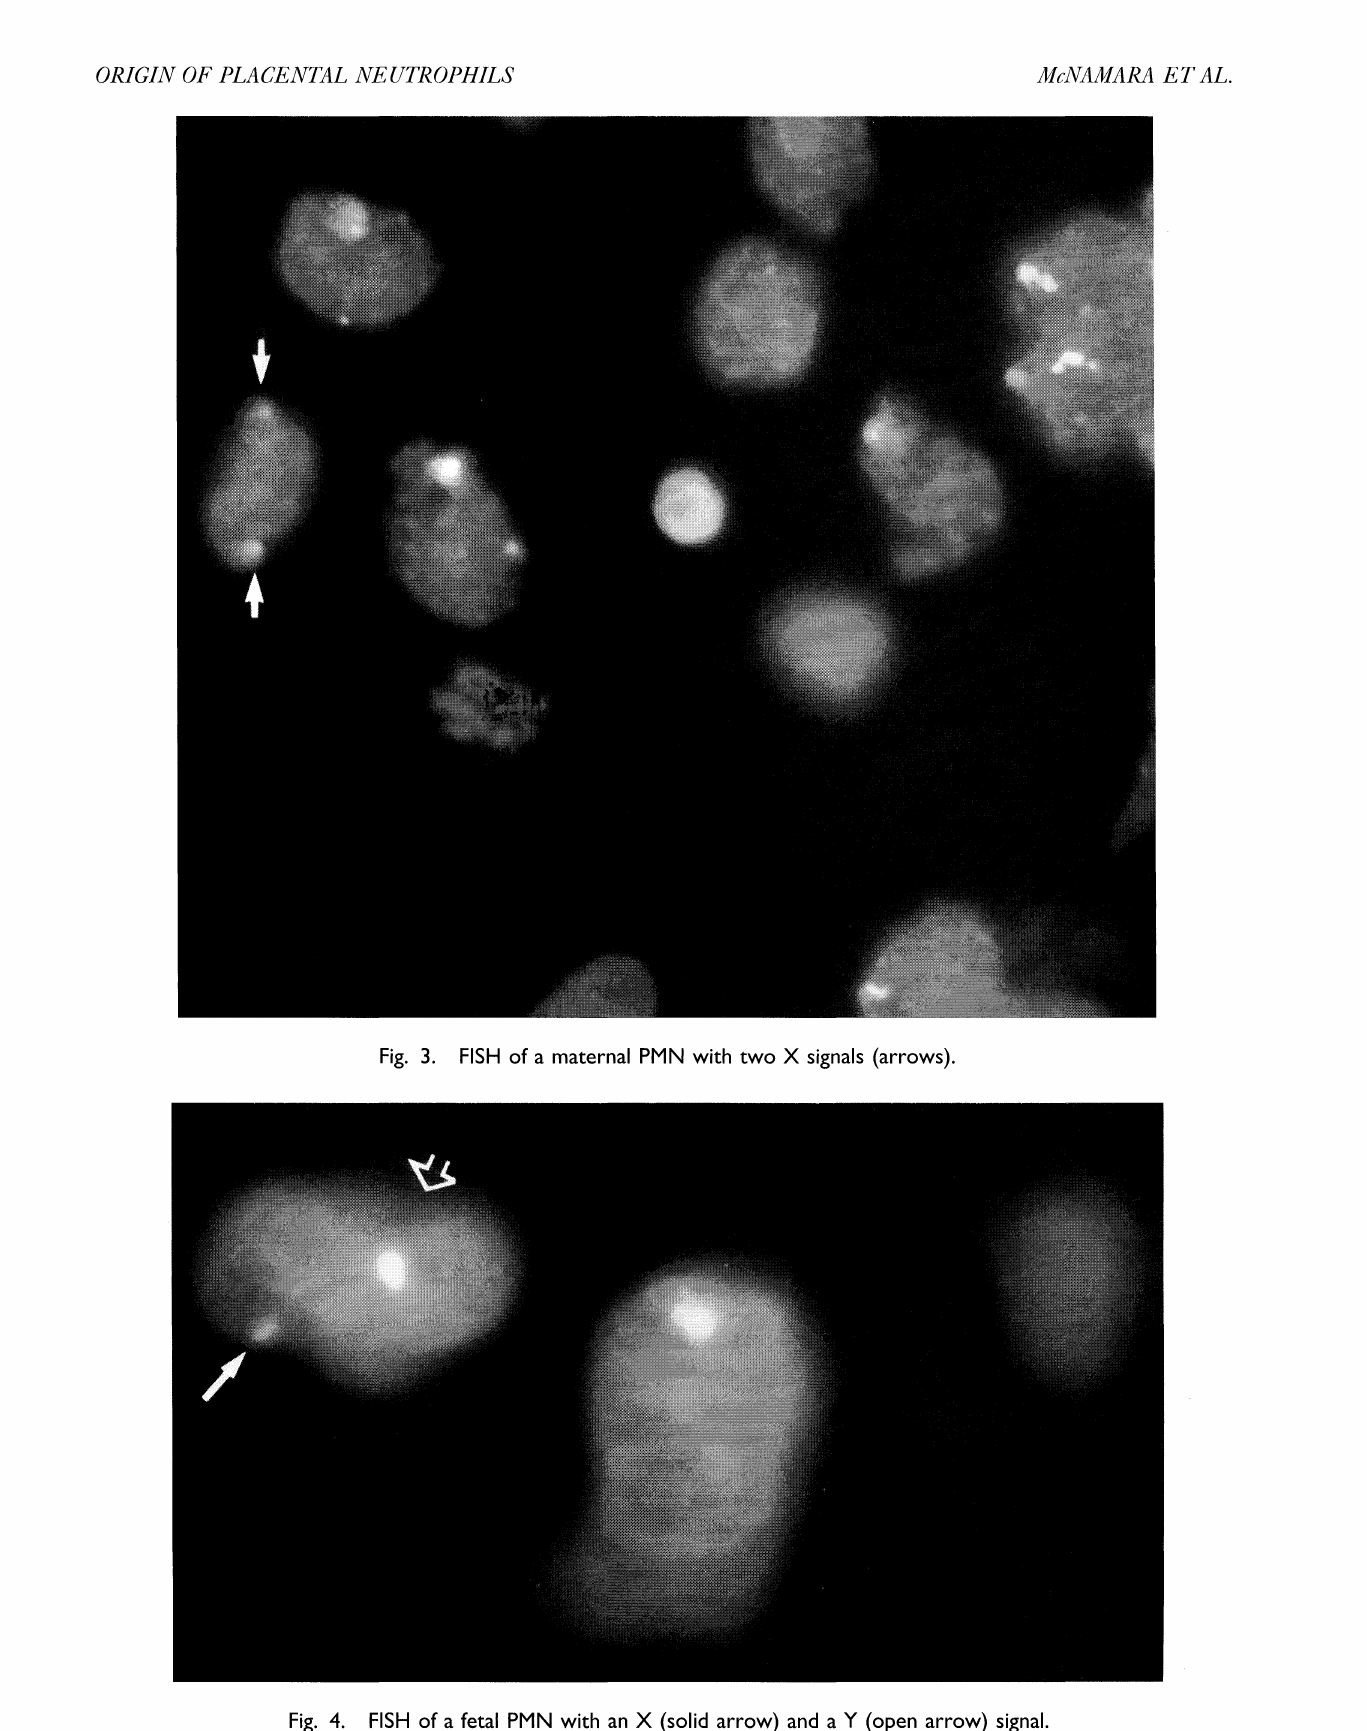
Fig. 4. FISH of a fetal PMN with an X (solid arrow) and a Y (open arrow)